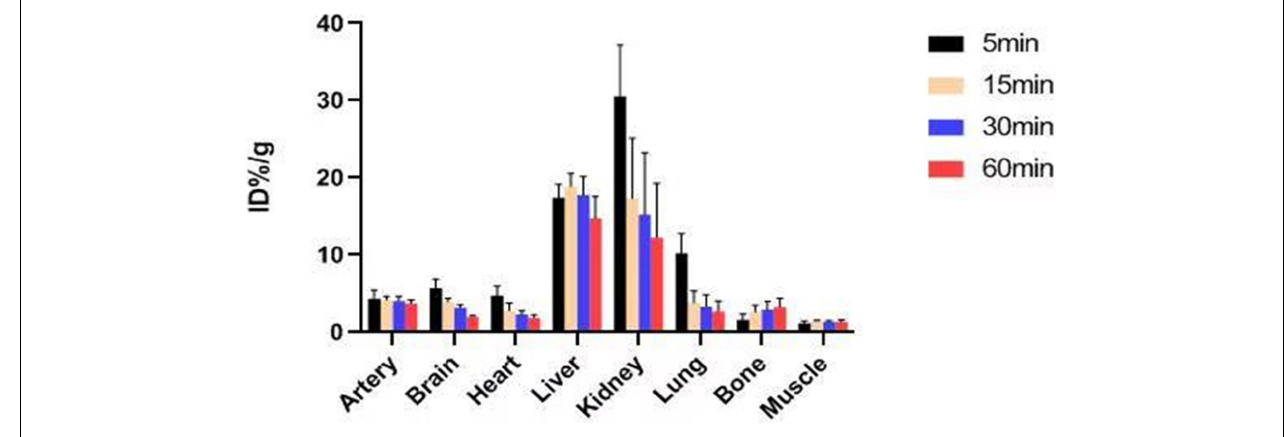
FIGURE 6 | Biological distribution map and table of normal mice.